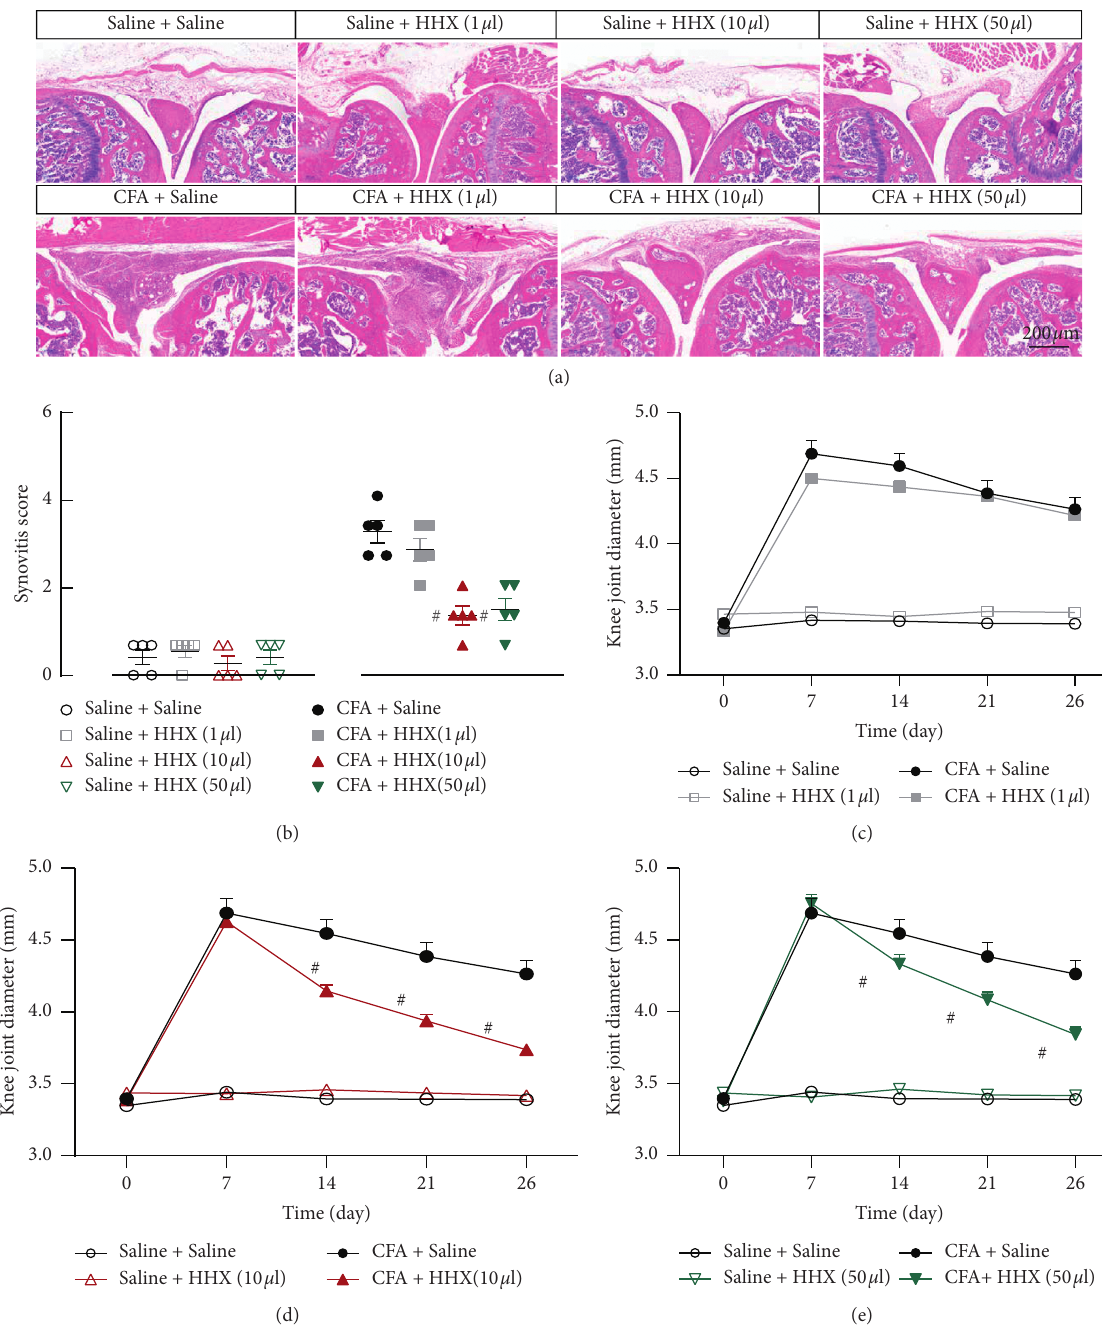
Figure 3: The anti-inflammatory effect of HHX in a mouse model of monoarthritis. (a) Histological changes of synovitis were observed in H&E-stained sections. Each knee joint shown was a representative for a group of mice; scale bars represents 200 μ m. (b) The synovitis scores for each group from the H&E-stained sections. Synovitis scores in CFA increased significantly ( t 8 � 9.391, P < 0 . 0001) and decreased in HHX at doses of 10 μ l and 50 μ l ( t 8 � 5.715, P � 0 . 0004; t 8 � 4.914, P � 0 . 0012), but not at the dose of 1 μ l ( t 8 � 1.134, P � 0 . 2897) at day 26. ((c)–(e)) The effect of HHX (1, 10, and 50 μ l) on knee joint thickness. CFA exhibited a significant increase in knee joint thickness (time × group interaction, F (4, 40) � 98.74, P < 0 . 0001). Time course of HHX at doses of 10 μ l and 50 μ l decreased the knee joint diameter (time × group interaction, F (4, 40) � 20.52, P < 0 . 0001; F (4, 40) � 14.45, P < 0 . 0001). However, HHX at doses of 1 μ l did not decrease the knee joint diameter (time × group interaction, F (4, 40) � 1.597, P � 0 . 1992). # P < 0 . 05 versus CFA